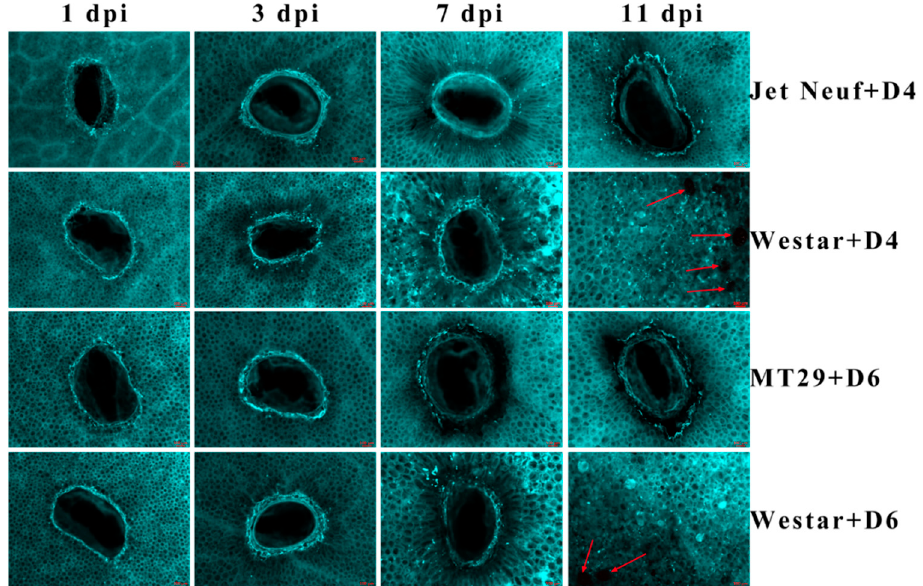
Figure 1. Staining of callose deposition in different B. napus varieties inoculated with different L. maculans isolates. Jet Neuf + D4 and MT29 + D6 indicate cotyledons of Jet Neuf, and MT29 were inoculated with D4 and D6 isolates, respectively. Westar + D4 and Westar + D6 indicate cotyledons of Westar were inoculated with D4 and D6 isolates, respectively. One, 3, 7 and 11 dpi indicate 1, 3, 7 and 11 days post-inoculation. Red arrows indicate the pycnidia produced by L. maculans . Three replicates were performed for each treatment and showed a similar pattern. Scale bars = 100 µ m. Table 1. Protein information of BnCalS gene family in Brassica napus . ORF stands for open reading frame. aa indicates the length of the protein. pI denotes isoelectric point.